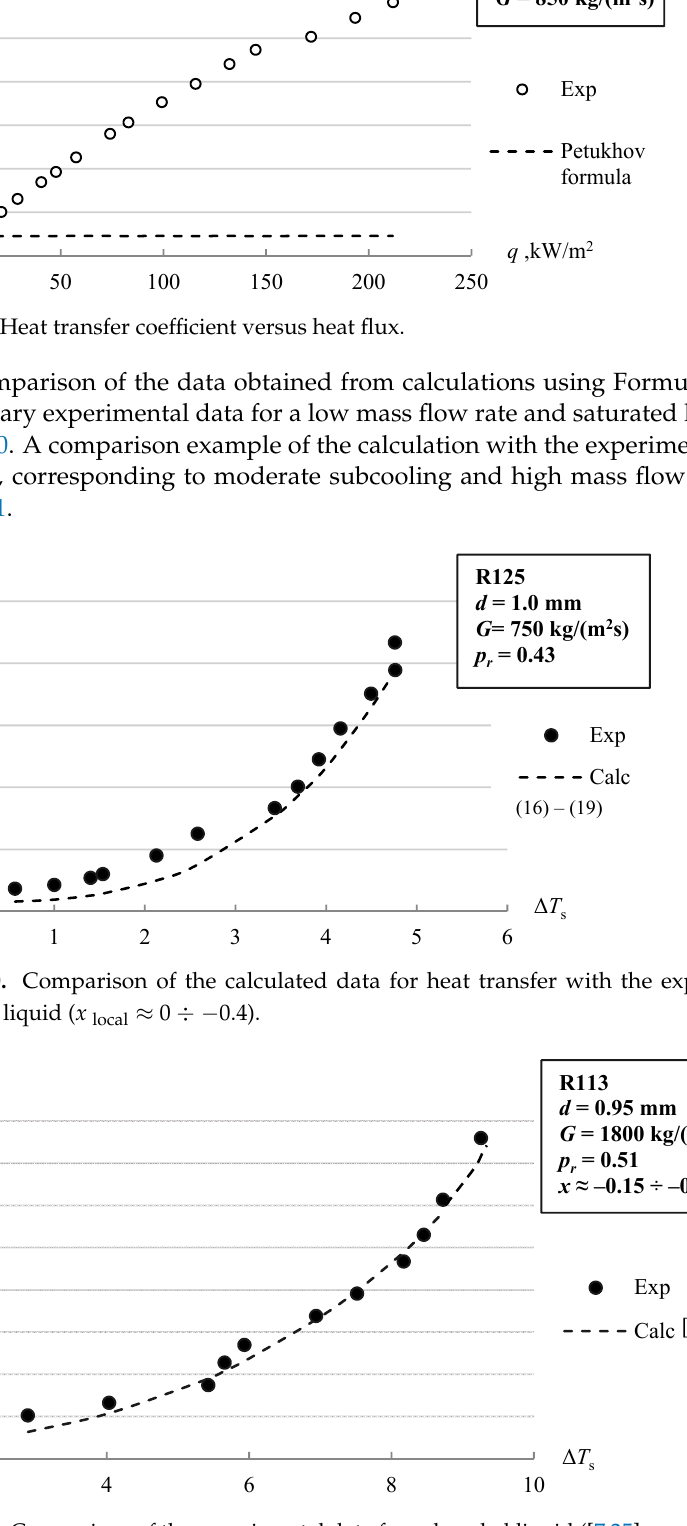
Figure 9. Heat transfer coefficient versus heat flux.